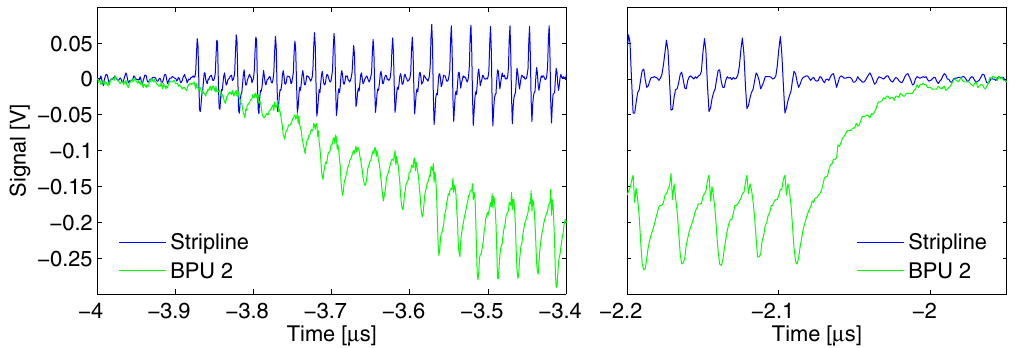
FIG. 5. (Color) Bunch-to-bunch electron cloud buildup (left) and decay (right) measured with button pickup #2 during the second last turn of the LHC beam. The 25 ns gap between successive bunches can be clearly resolved with the stripline electrode.